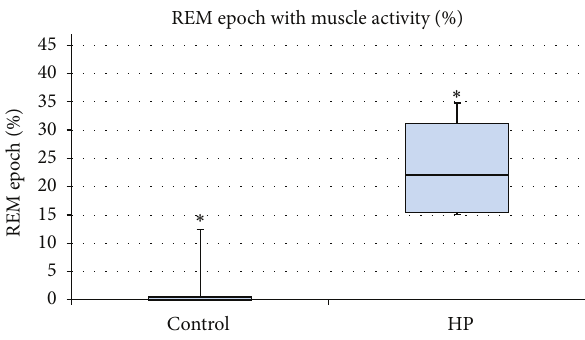
Figure 5: Percentage of REM epoch with muscle activity in control ( 𝑛 = 5 ) and HP ( 𝑛 = 5 ) groups. Comparison of mean difference indicates a significant increase in muscle activity during REM sleep in HP rats compared to control rats ( 𝑃 value